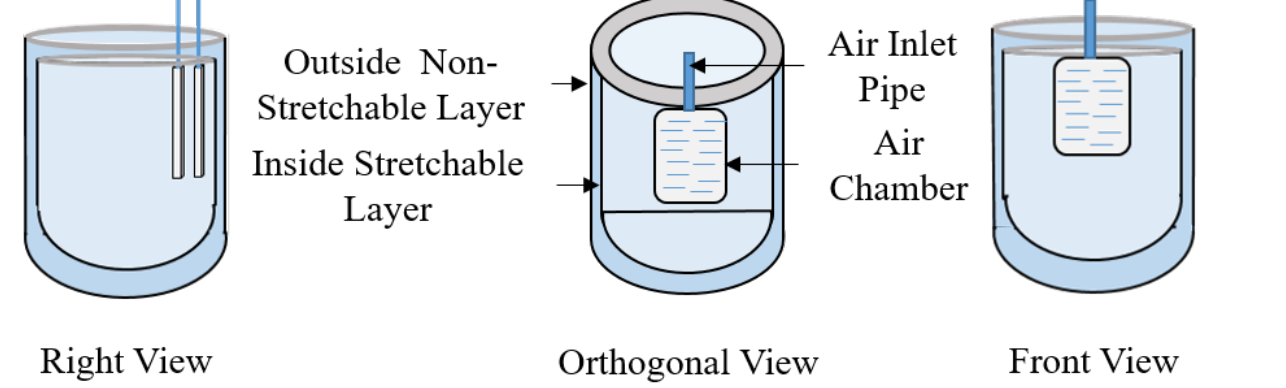
Figure 2. Design and structure of the